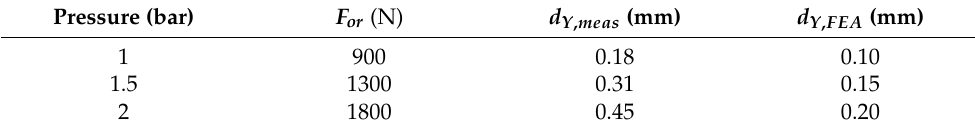
Table 8. Measured and calculated values of axial displacement at different pressure levels. Pressure